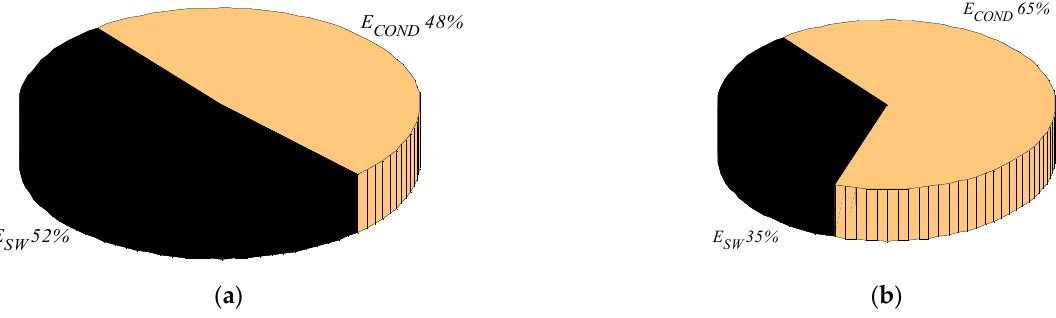
Figure 7. Distribution Semiconductor Losses. ( a ) FCS–MPC with k sw = 0.00, ( b ) FCS–MPC with k sw =